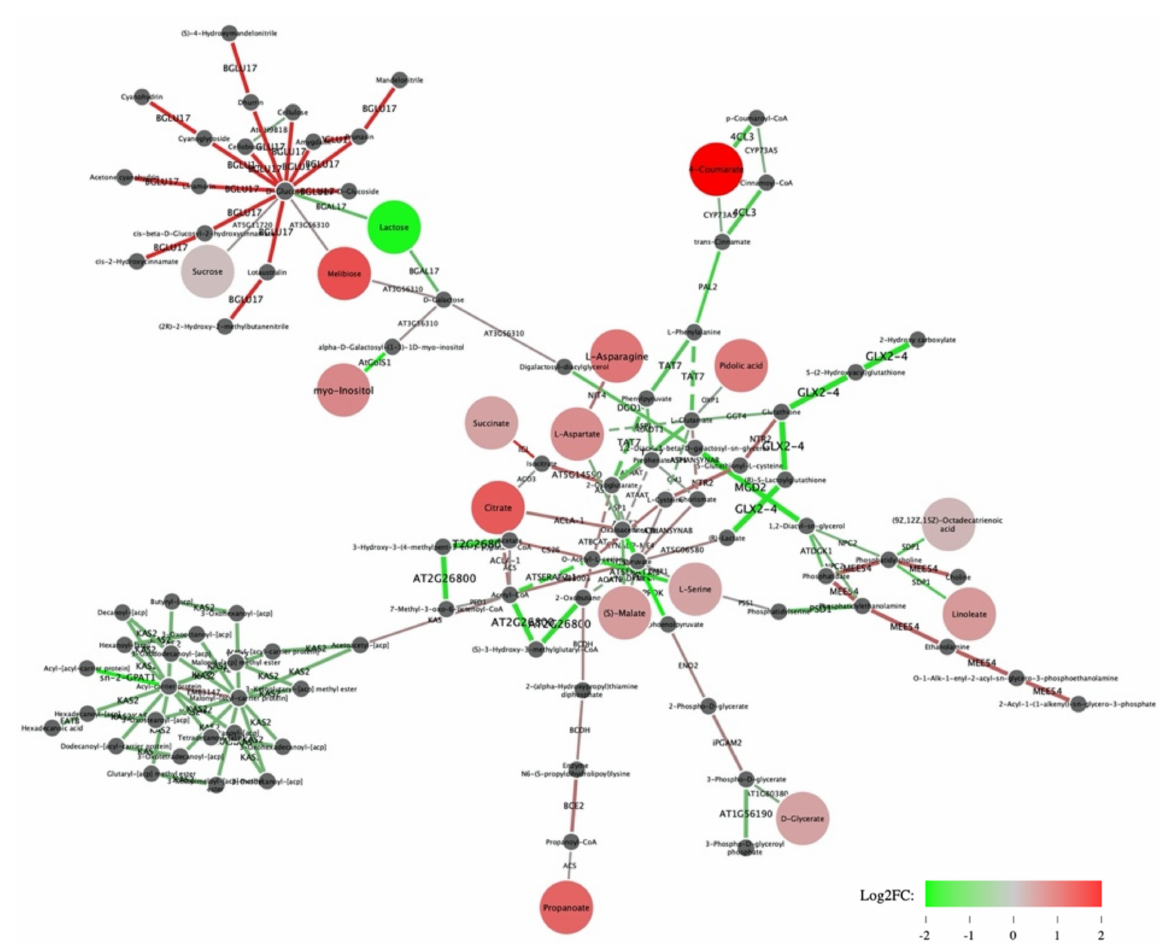
Figure 3. Transcriptome-metabolome network obtained with Shiny GAM. Green edges correspond to genes downregulated in Early flowering plants, red edges correspond to overexpressed genes. Green nodes correspond to metabolites whose negative log 2 fc value means lower concentrations in EFl plants compared to DFl plants, red nodes are metabolites ‘overex- pressed’ in EFl. The nodes with increased size correspond to metabolites with significant p -value in 2019. Dark grey small nodes indicate metabolites with p -value >